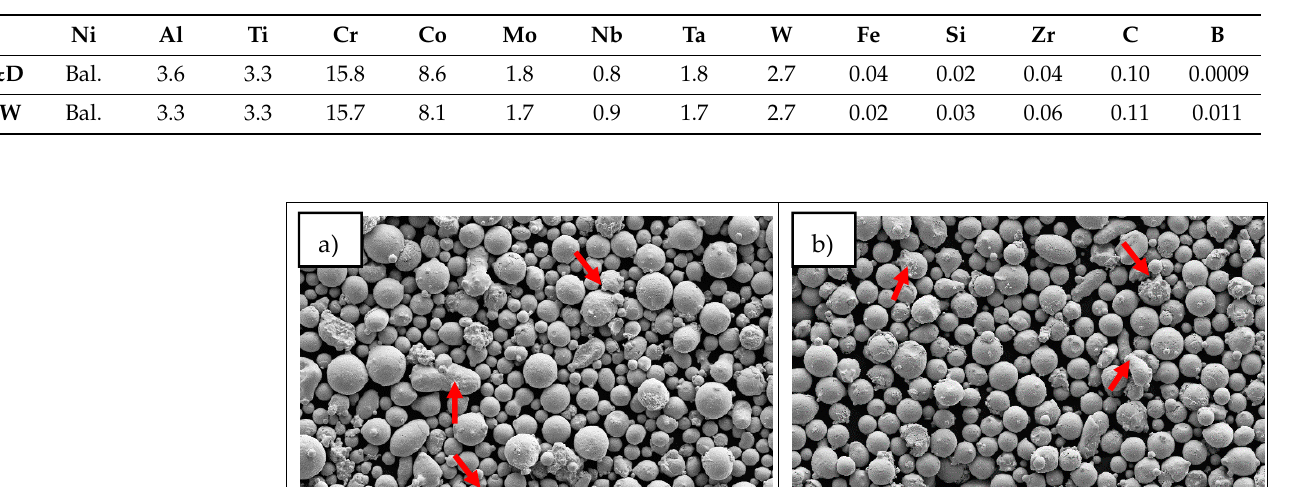
Table 1. Chemical composition (weight %) of Aubert and Duval and LPW IN738LC powders.